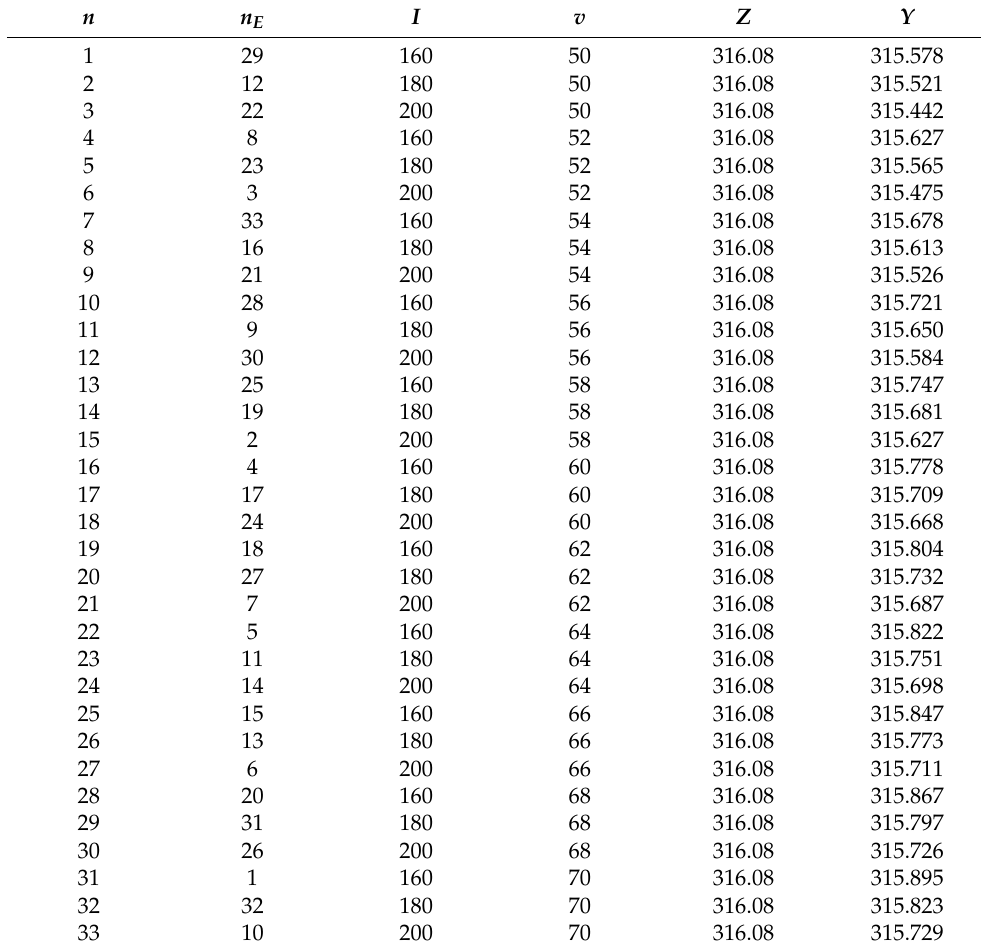
Table 4. Measurements—testing